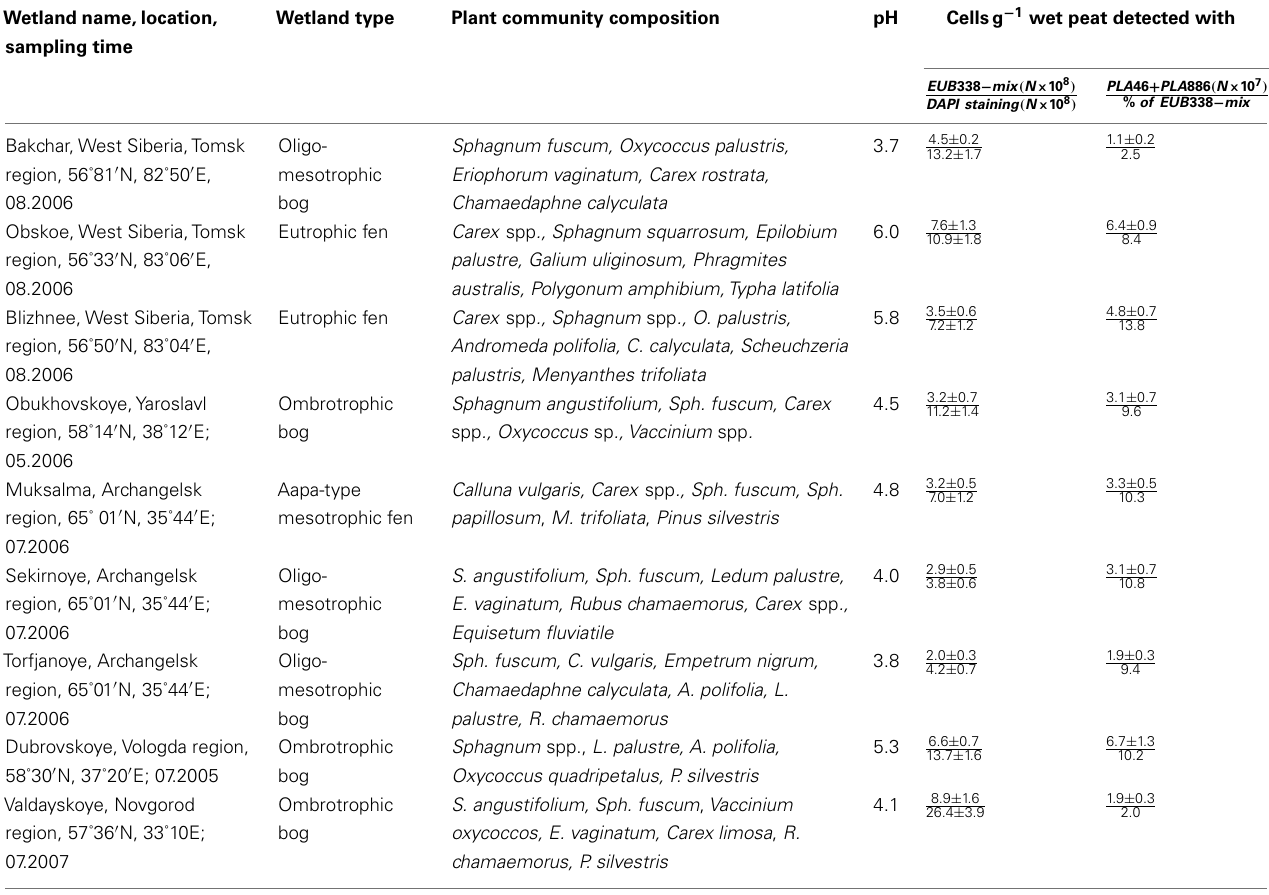
Table 1 |The number of cells detected by FISH with the Planctomycetes -specific probes in acidic northern wetlands of different geographic location (data are presented for the uppermost (0–10cm) peat bog layer corresponding to the maximal number of planctomycete cells detected over the bog profile).